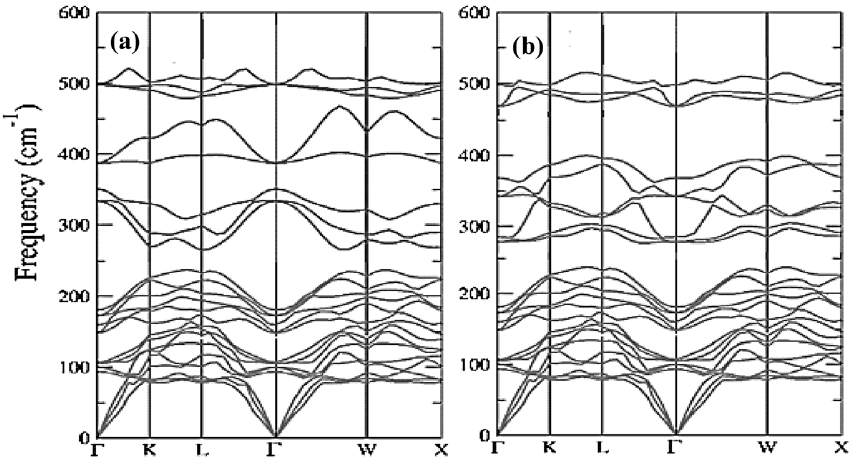
Figure 3. (a , b) Phonon dispersions along the high symmetric directions of Brillouin zone of ( a ) Ba 2 ErNbO 6 and ( b ) Ba 2 TmNbO 6